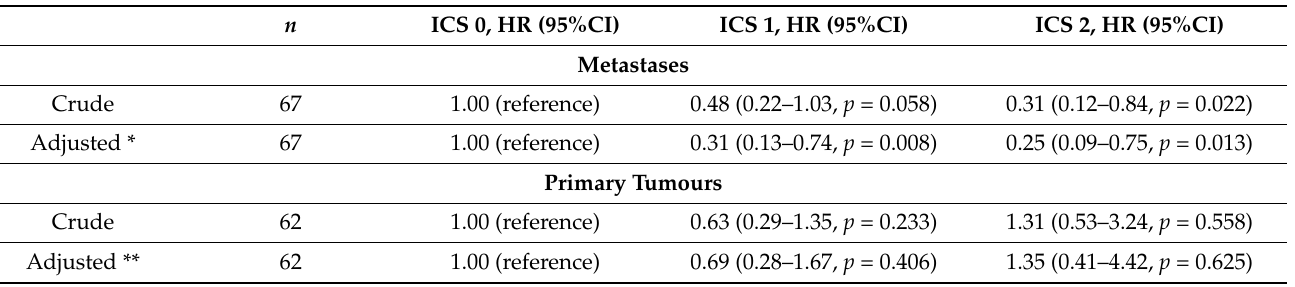
Table 3. Hazard ratios (HR) for 5-year all-cause mortality with 95% confidence intervals in pulmonary metastases and primary colorectal tumours stratified by ICS